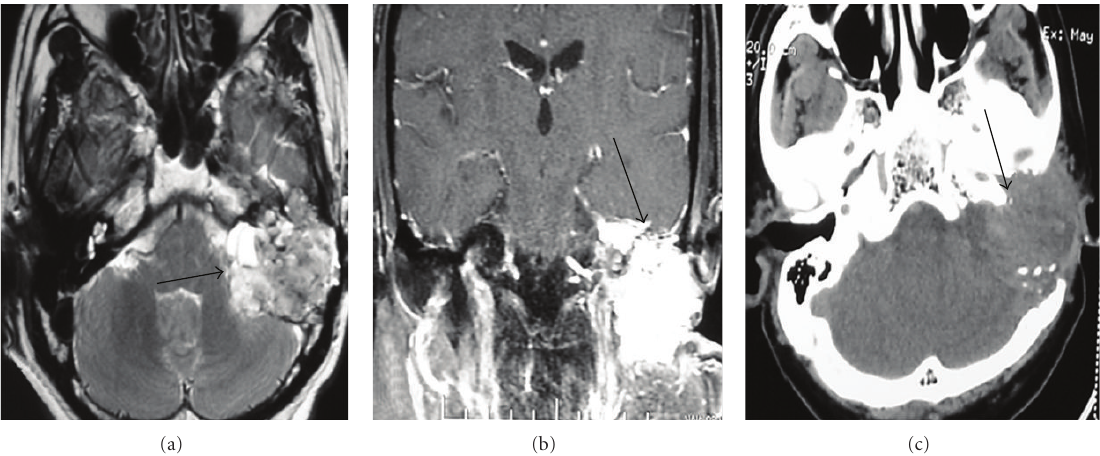
Figure 1: Axial MRI T2-weighted image (a) and contrast-enhanced coronal T-weighted image (b) showing heterogenous intensely enhancing mass involving left petrous temporal bone causing destruction of bone, extending medially left cerebellopontine angle cistern and inferiorly below base of skull. Axial CT scan (c) showing destruction of extensive destruction of the posterior petrous bone and middle ear structures.